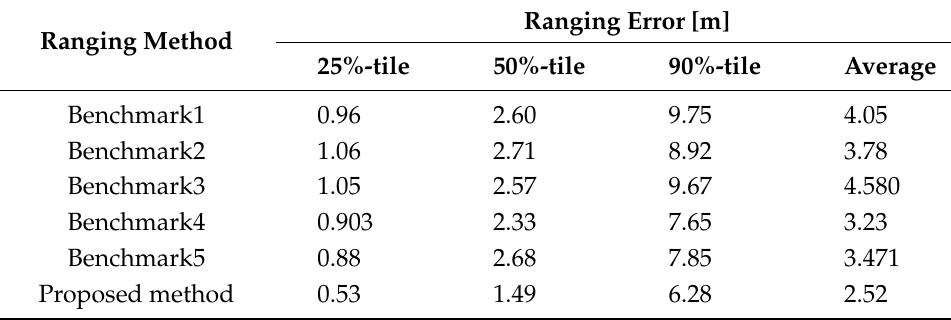
Figure 10. Empirical cumulative distribution function (ECDF) of the ranging error. Table 1. Ranging error results of each ranging